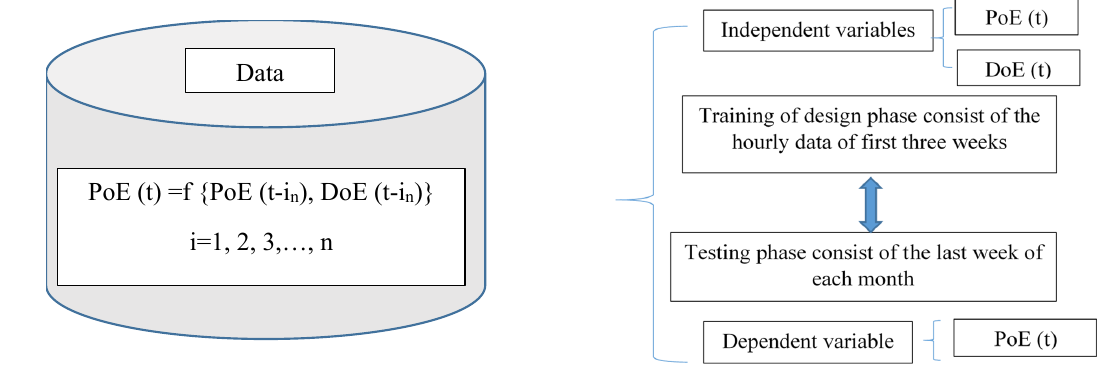
Figure 4. Process of obtain AI-Based Models for Short-Term EPF.